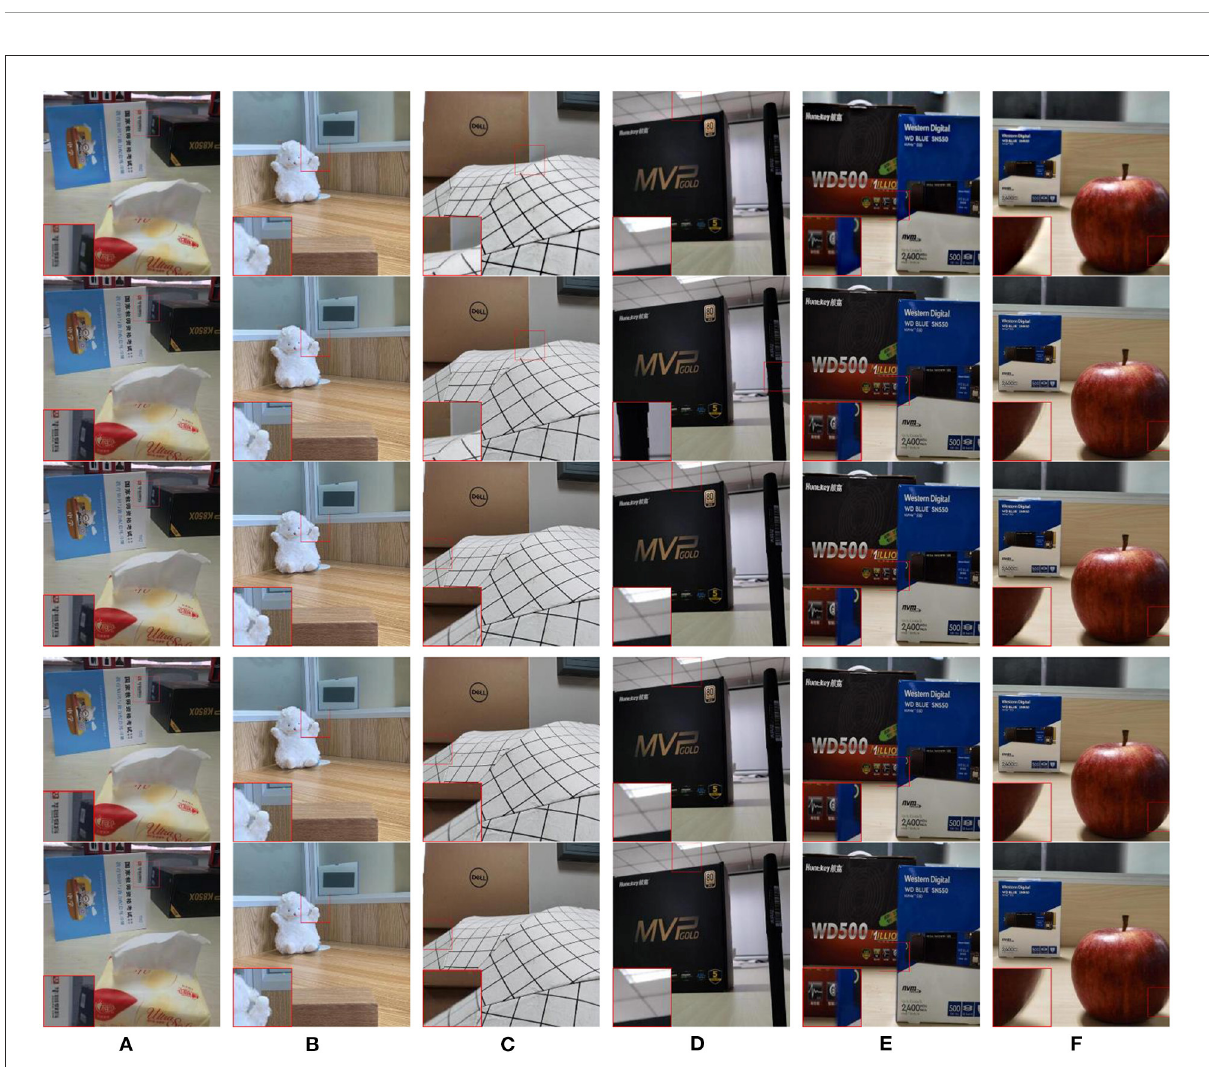
FIGURE5 Fusion results of different algorithms. (A–F) are the fusion results of MGF, DSIFT, IFCNN, CNN, and SESF, respectively.